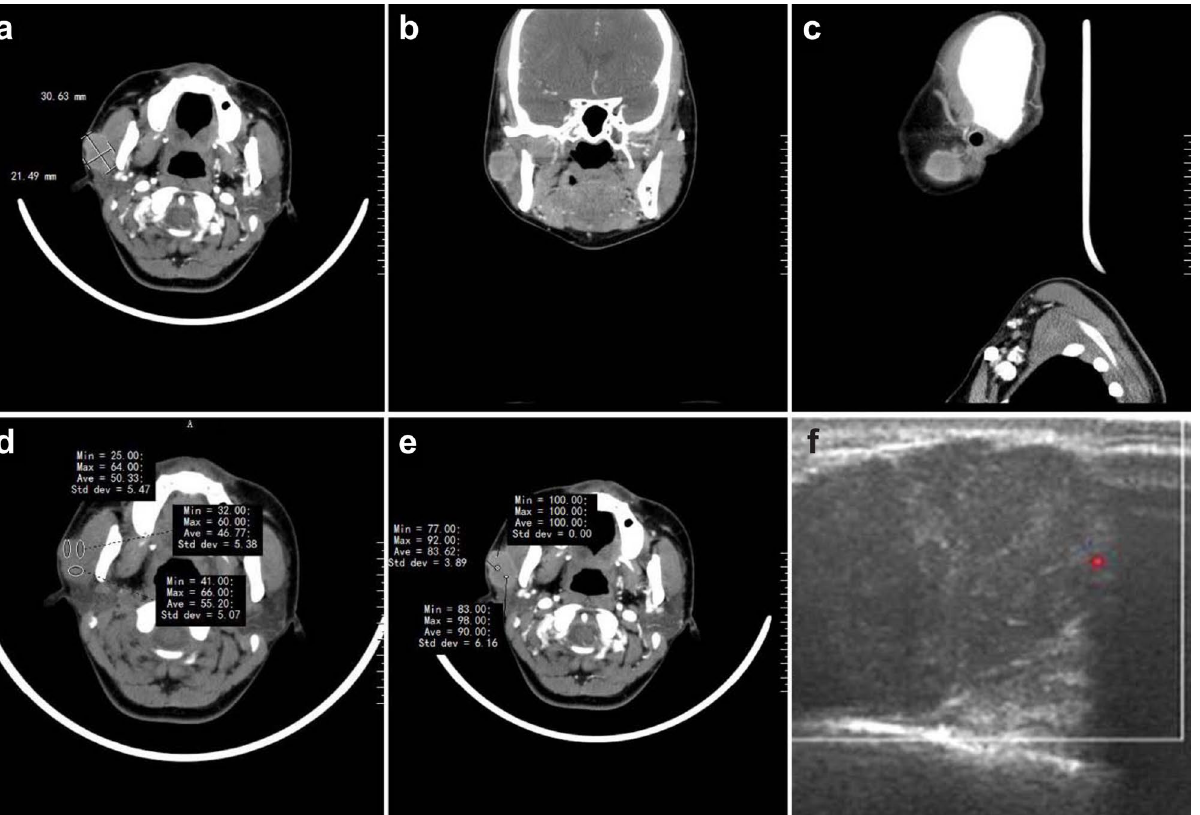
Figure 2. Color Doppler ultrasound and computed tomography (CT) imaging findings of typical SCSG. In CT, the lesions appeared oval or lobulated, with clear boundaries, regular edges, and uneven density. ( a ) Horizontal plane; ( b ) coronal plane; ( c ) sagittal plane. ( d ) Average Hounsfield unit (HU) was 42 (41.69 ± 16.5) with plain scanning, and ( e ) 76 (76.1 ± 24.7) with enhanced scanning. ( f ) Typical ultrasonic characteristics.